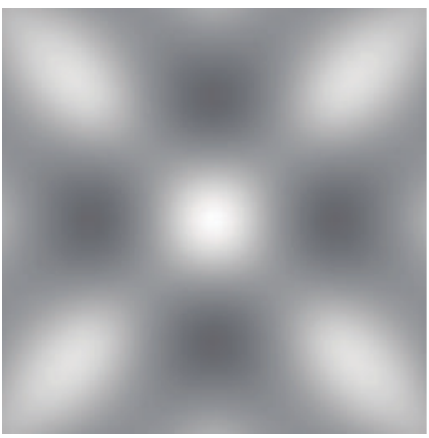
Figure 7: Results.